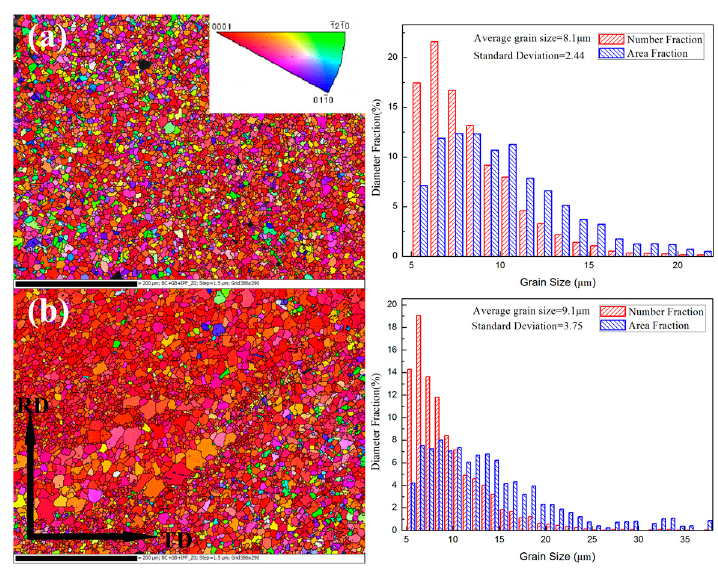
Figure 6. EBSD results of AZ31 alloys HSRMFed to different accumulated strain with a pass strain of ∆ ε = 0.35, ( a ) 1.4 and ( b ) 1.75.